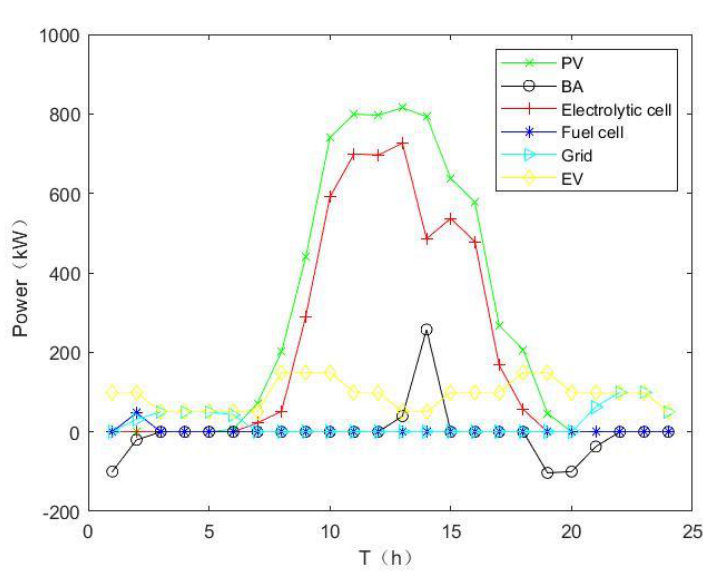
Figure 5. Electric power balance.